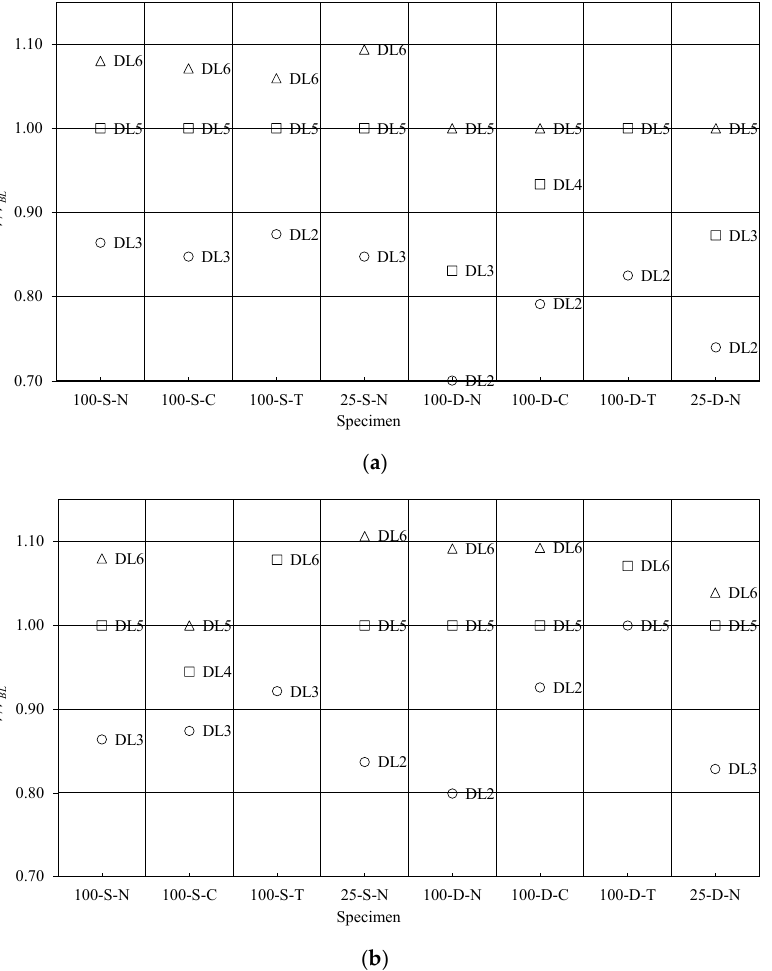
Figure 10. Comparison of damage levels between different test specimens based on V / V BL (DL1: Front face indentation without cracks; DL2: Rear face cracks without scabbing. No cracks are visible on the front face; DL3: A cavity formed on the front face with radial cracks; The back face has significant cracks; DL4: A cavity on the front face with scabbing on the back; DL5: There is almost no residual velocity after perforation; DL6: Perforation with residual velocity) for slabs of the concrete mix: ( a ) M1; and ( b ) M2.